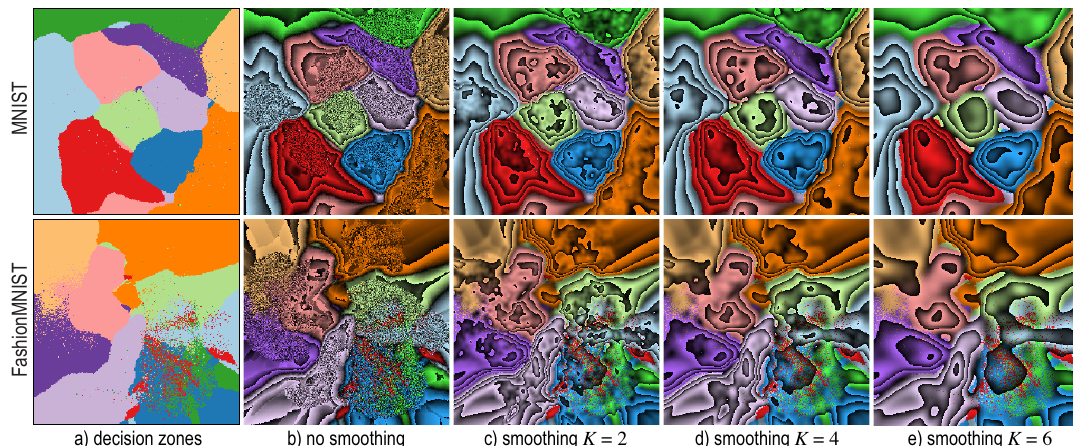
Figure 13. Enridged distance maps for MNIST (top row) and FashionMNIST (bottom row) datasets. Images ( b – e ) show the progressive noise-smoothing effect of the filter radius K